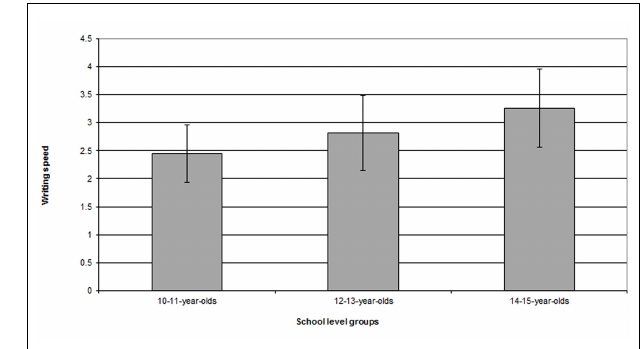
FIGURE 3 | Mean writing speed in draft texts as a function of school level